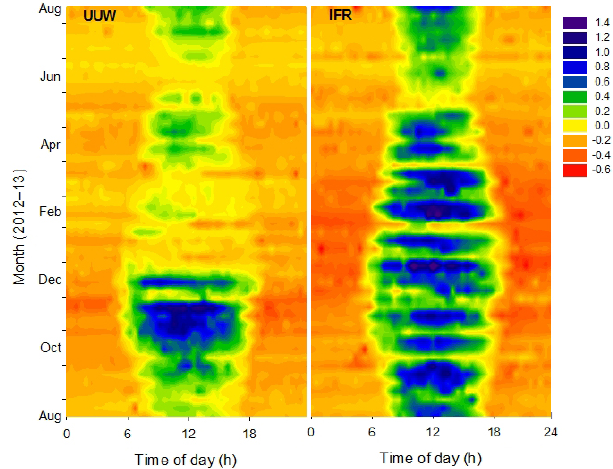
Figure 5. Visualisation of diurnal variation (horizontally) and seasonal variation (vertically) of net ecosystem production (g Cm − 2 h − 1 ) for the UUW and IFR pastures. Positive values (in yellow, green and blue) represent net C uptake by the ecosystem and negative values (in orange and red) represent net C losses.